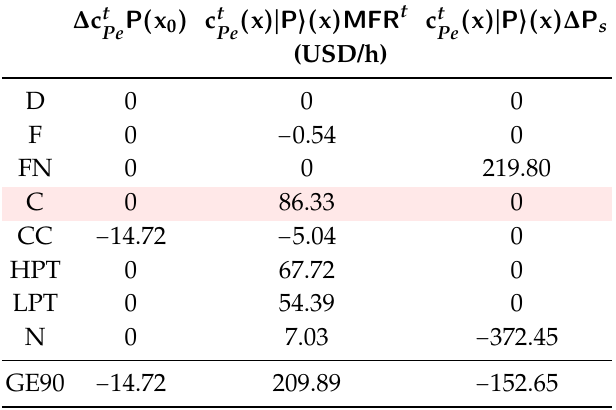
Table 8. Exergoeconomic cost decomposition of fuel